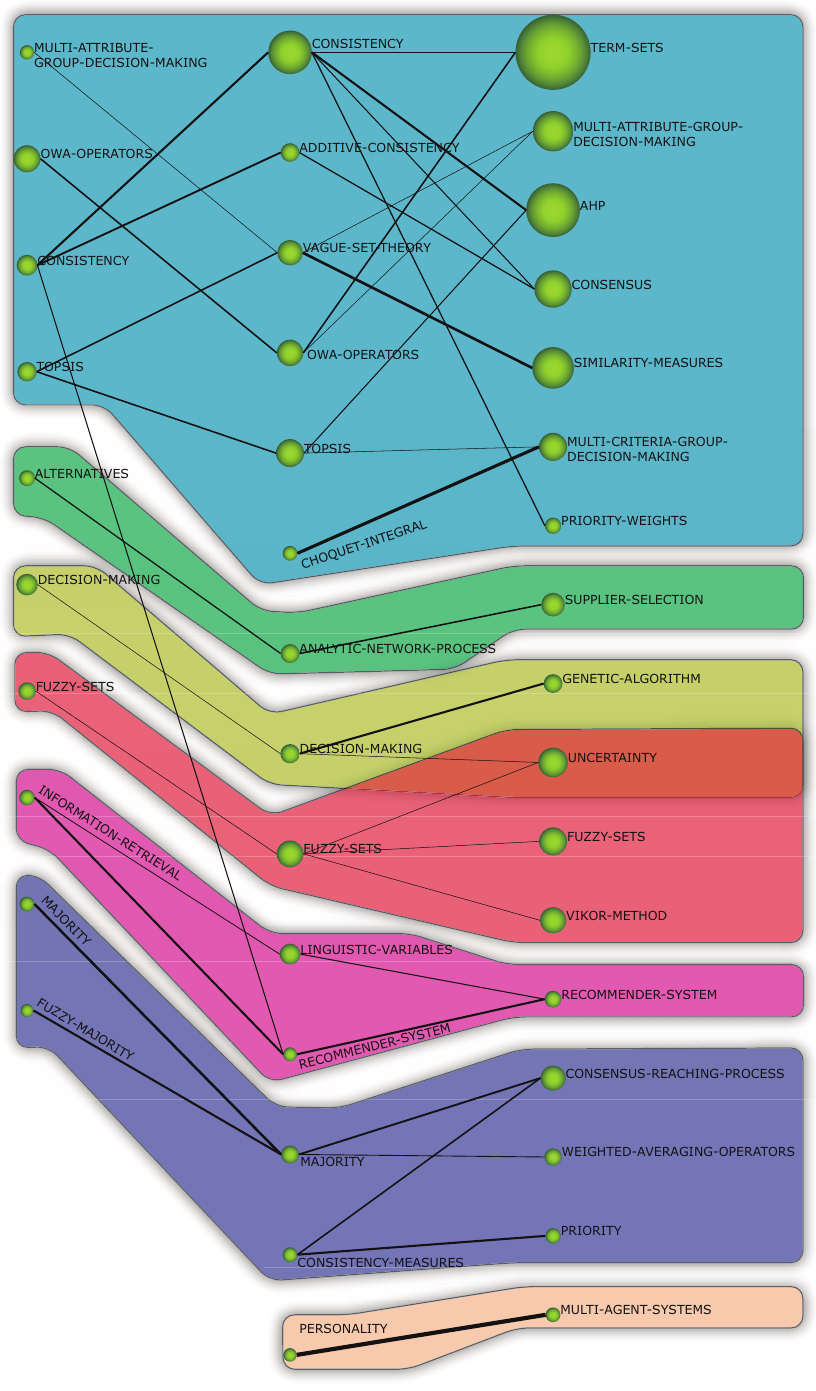
Figure 15. Thematic areas’ conceptual